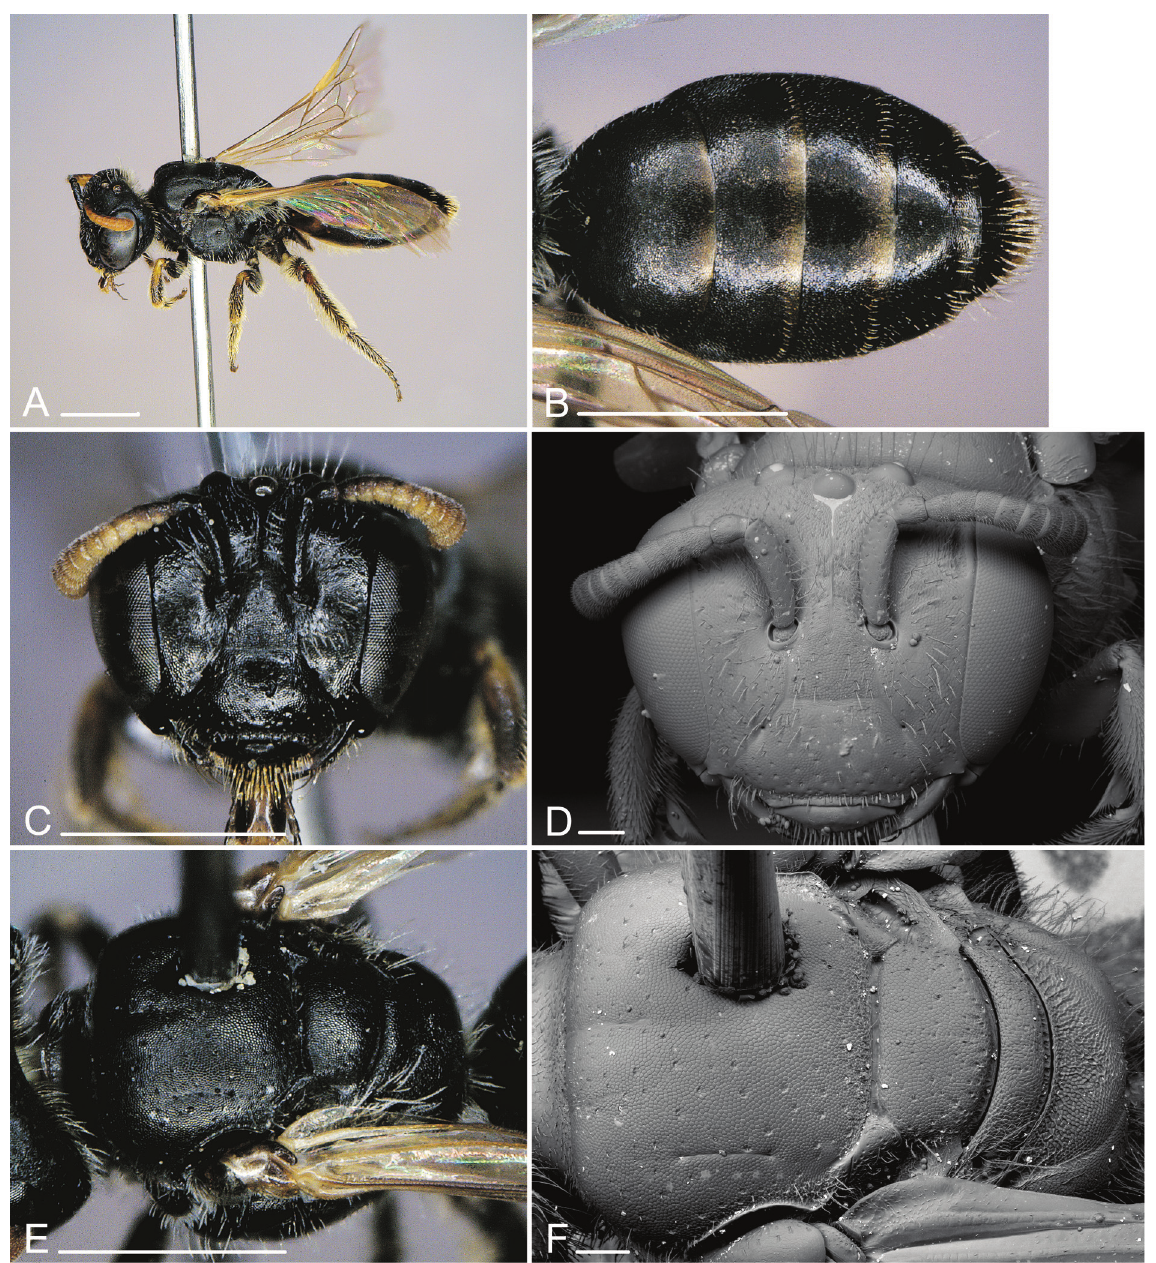
Fig. 11. Scrapter luteistigma sp. nov., ♀. A . Lateral view. B . Metasoma (dorsal view). C . Head. D . Head (SEM). E . Thorax (dorsal view). F . Thorax (dorsal view, SEM). Scale bars: photos: 1 mm, SEM: 0.1